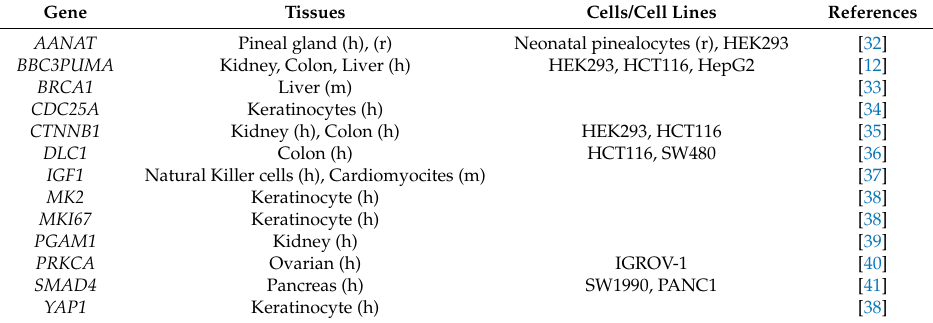
Figure 1. Stem-loop sequence of the hsa-miR-483 and mature miRNAs. In the Figure are reported genomic position, sequence of the hsa-miR-483 gene. Sequences data from miRBase database [27–31]. Table 1. miR-483-3p verified targets. (h), (r) and (m) indicate respectively human, rat and murine tissues. Gene Tissues Cells/Cell